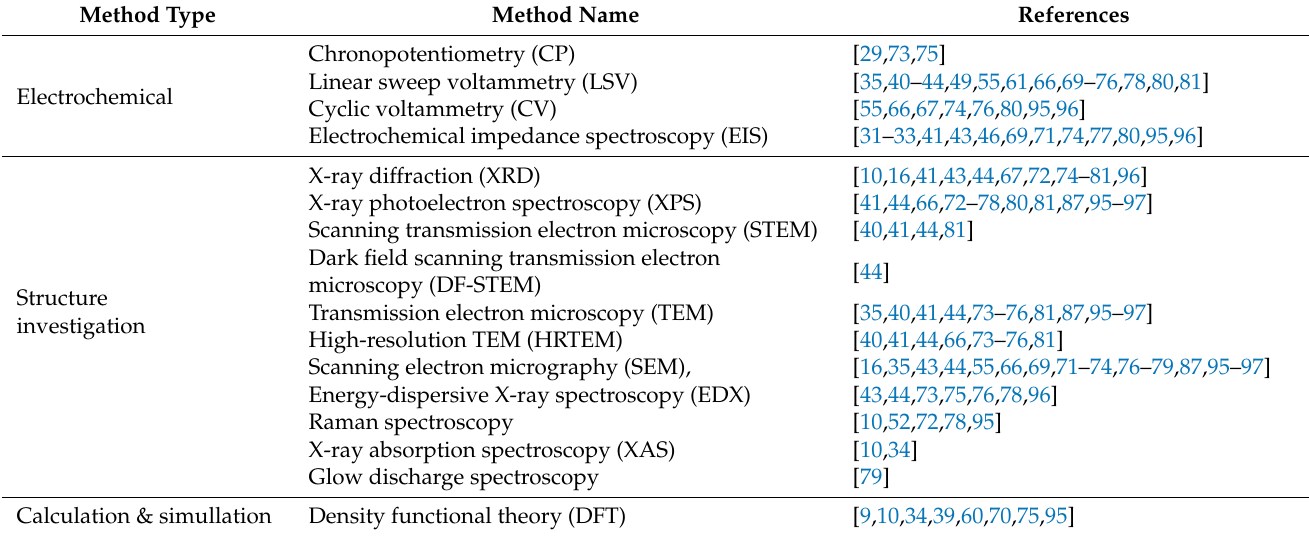
Table 5. Investigation methods for characterizing the properties of water/seawater